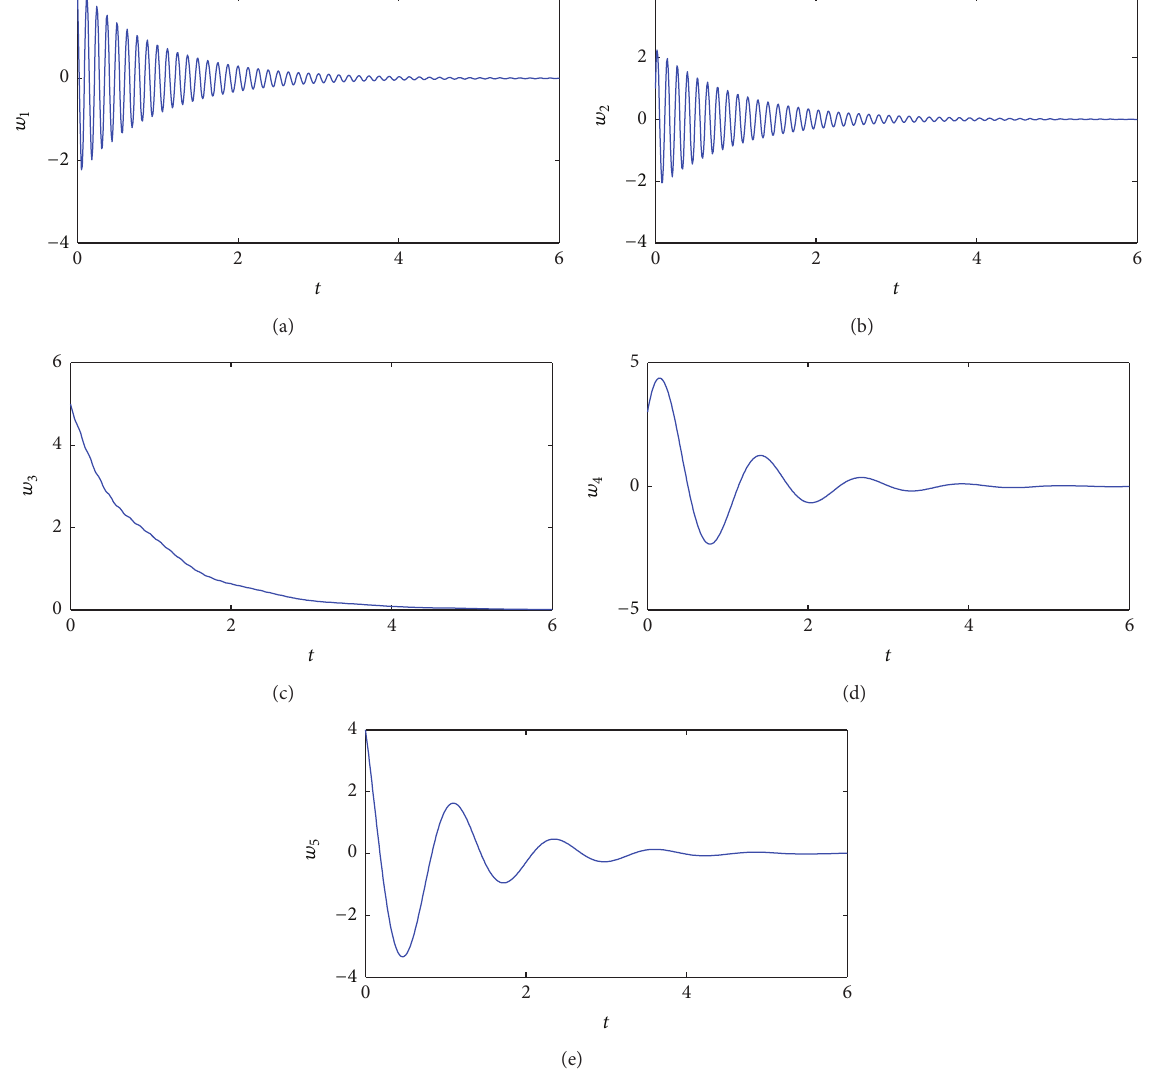
Figure 7: Time evolution of the states of system